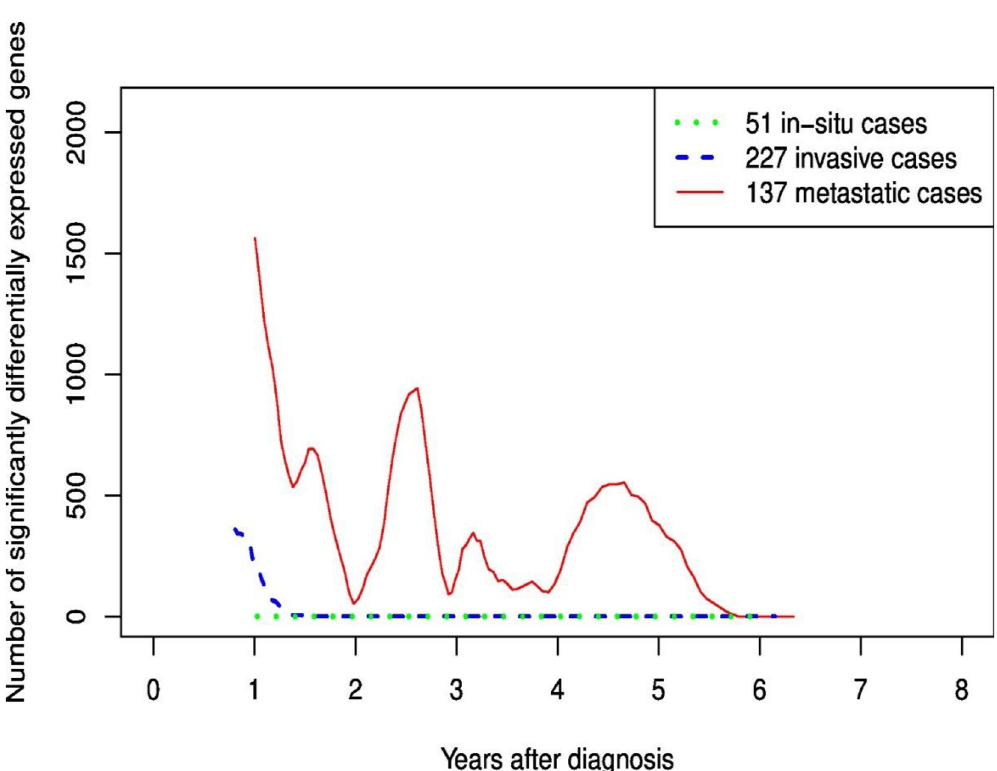
Fig 3. Number of significantly differentially expressed genes for each follow-up time period stratified on stage of breast cancer; invasive and metastatic.